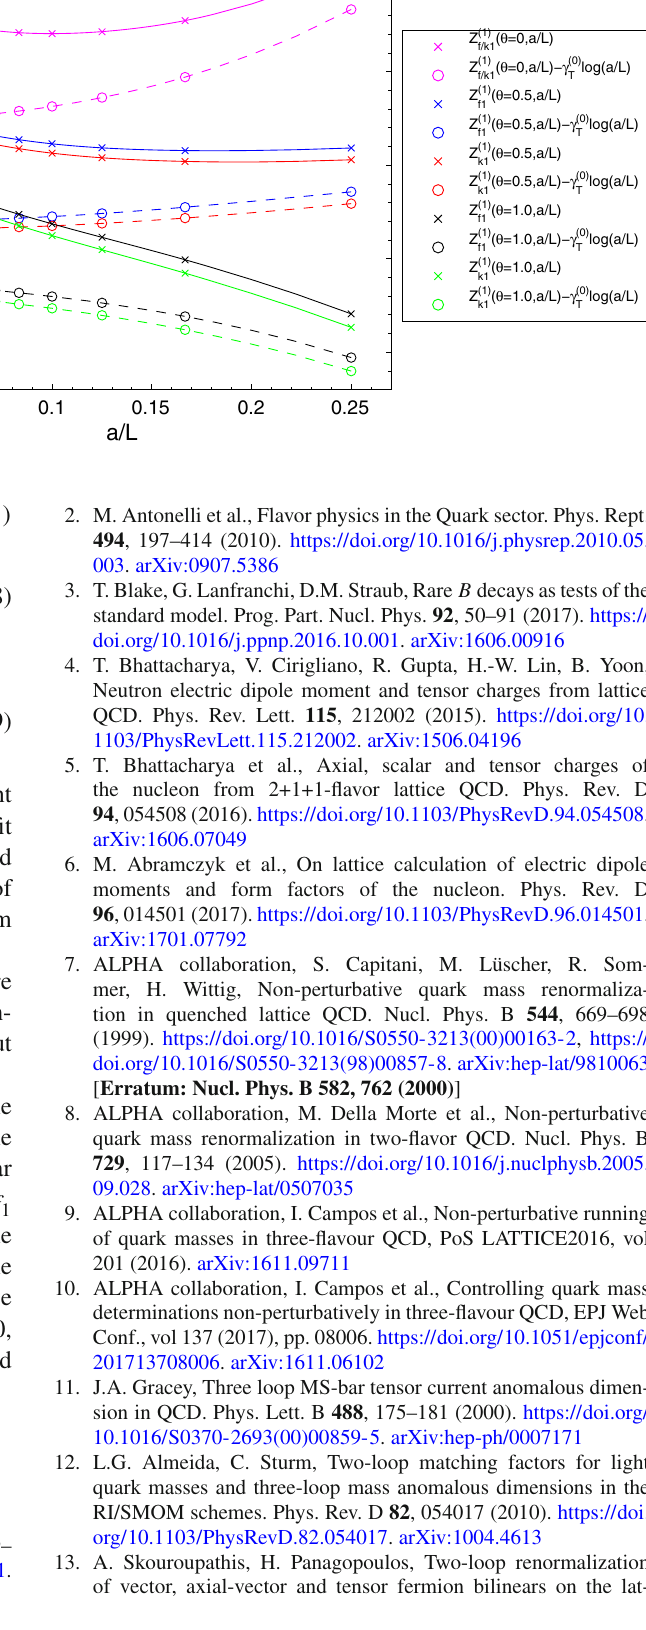
Fig. 13 One-loop renormalization constants for the three values of θ = 0 , 0 . 5 , 1. The a / L dependence